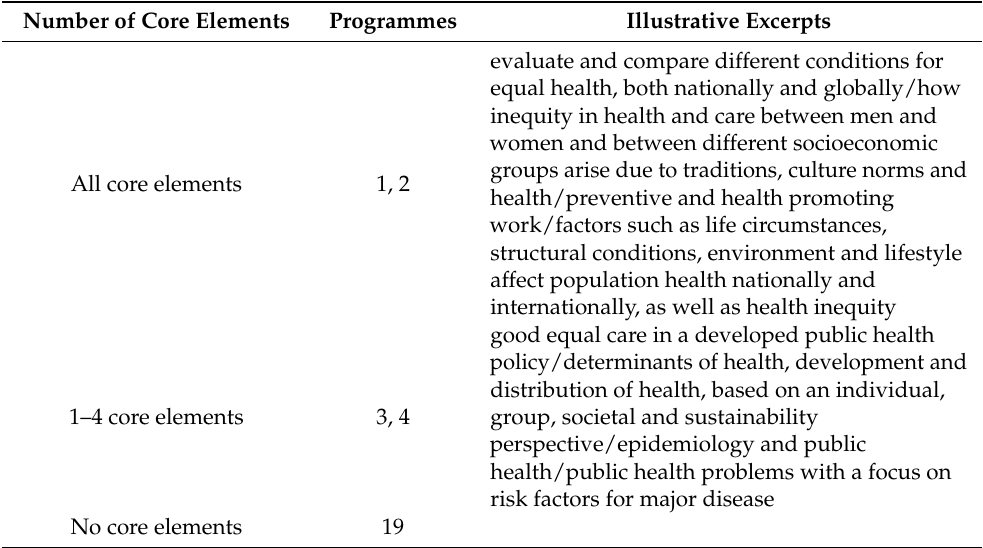
Table 2. Syllabi grouped under the theme Public Health.